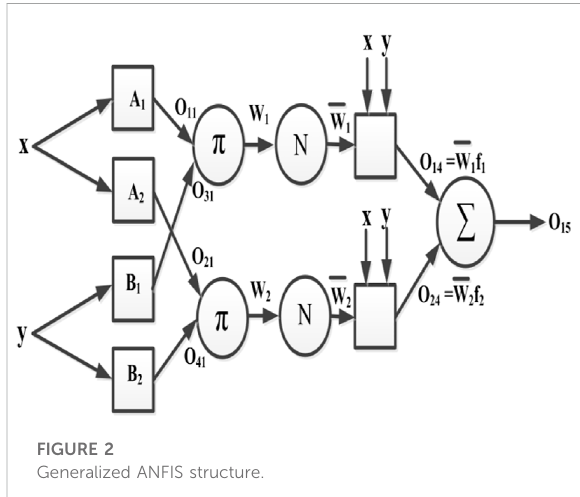
FIGURE 2 Generalized ANFIS